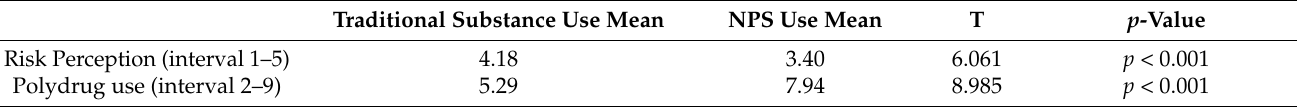
Table 5. Differences in risk perception and polydrug use between NPS and traditional